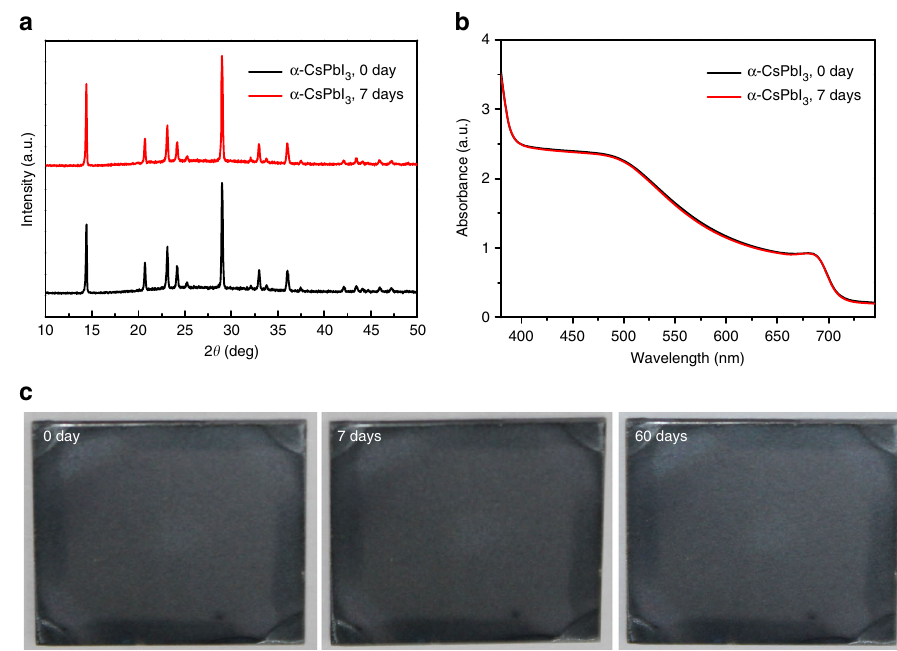
Fig. 2 Phase stability of α -CsPbI 3 fi lms in dry nitrogen environment. a X-ray diffraction (XRD) of CsPbI 3 -precursor fi lms annealed at 350 °C for 10 min, all the diffraction peaks from the α -phase of CsPbI 3 , and also the XRD pattern of α -CsPbI 3 after storing in a dry nitrogen box for 7 days. b Absorption of the α -phase of CsPbI fi lms before and after 7 days of storage in dry nitrogen. c Images of annealed CsPbI 3